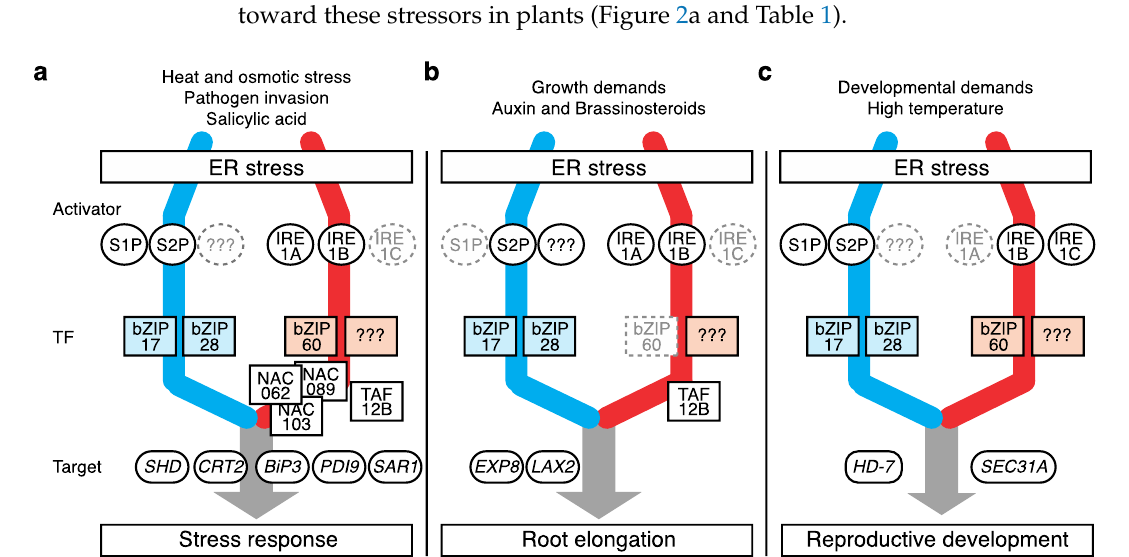
Figure 2. Different modes of plant UPR action. Plant UPR components governing biological processes including ( a ) canonical stress response, ( b ) root elongation, and ( c ) reproductive development. Components with an auxiliary role are marked in gray. Suspected but unknown components are marked as “???”. Only representative targets are shown. The color scheme for the two UPR pathways is the same as that in Figure 1. Table 1. Physiological defects and characteristics of knockout mutants of UPR components in Arabidopsis ( A. thaliana ).